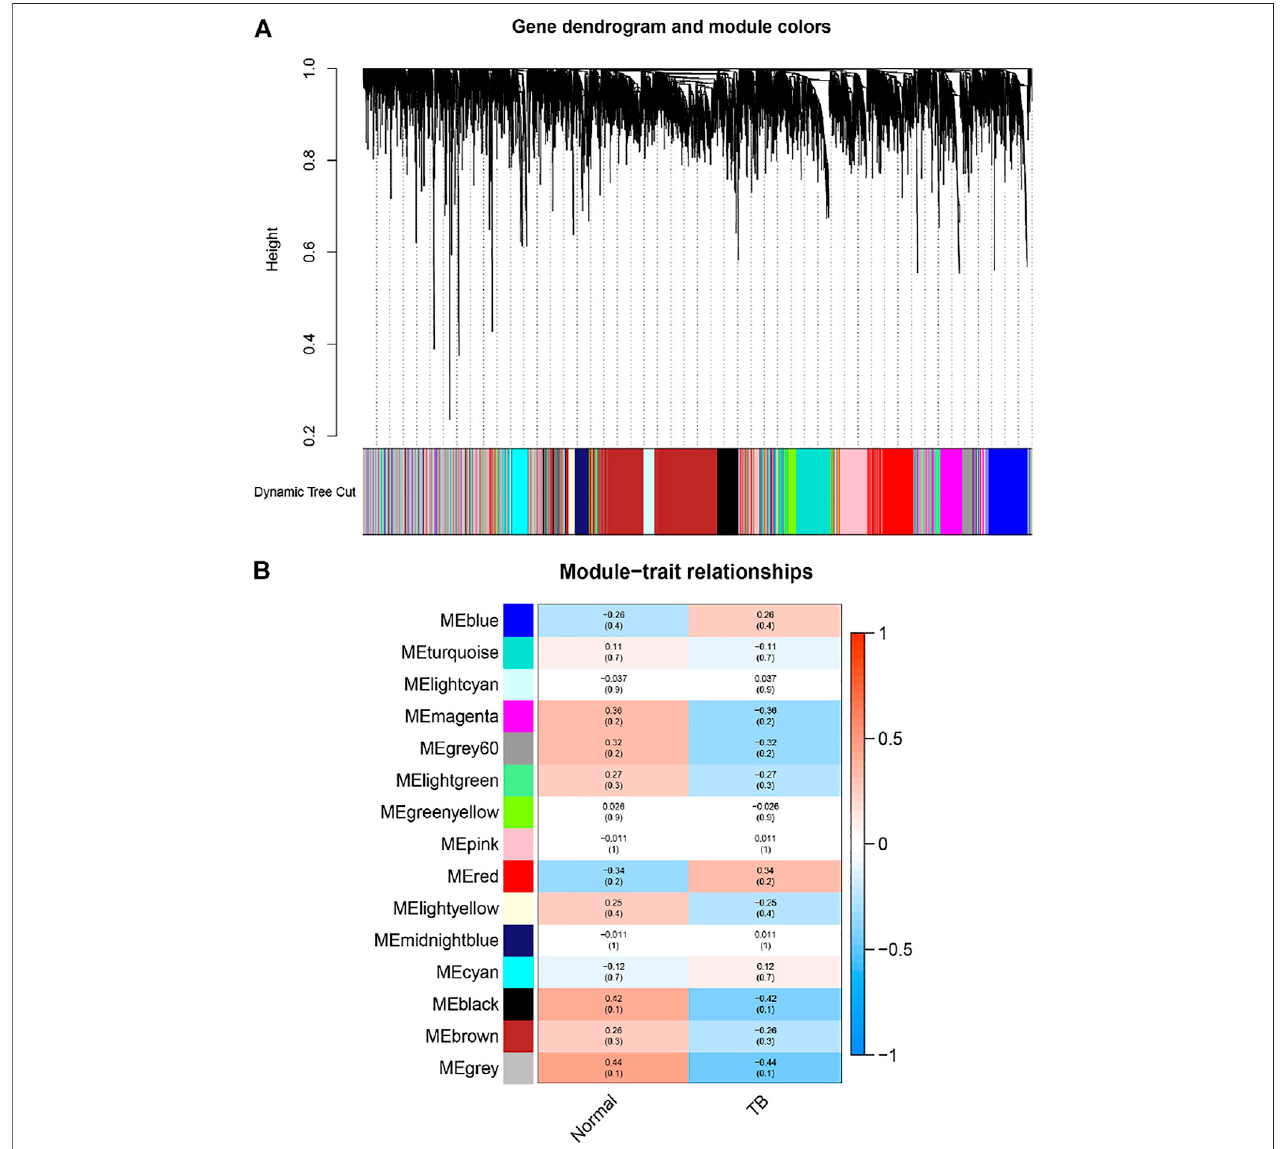
FIGURE 2 | Identi fi cation of modules associated with the clinical information in the dataset. (A) The Cluster dendrogram of co-expression network modules was ordered by a hierarchical clustering of genes based on the 1-TOM matrix. Each module was assigned different colors. Each module contains genes that belong to the same center in a weighted co-expression network. These genes in module had the same expression pro fi les. (B) Module-trait relationships. Each row corresponds to a colormoduleandcolumncorrespondstoaclinicaltrait(TBandnormal).Eachcellcontainsthecorrespondingcorrelationand p -value.Themodulewiththehighest correlation coef fi cient had the greatest association with tuberculous